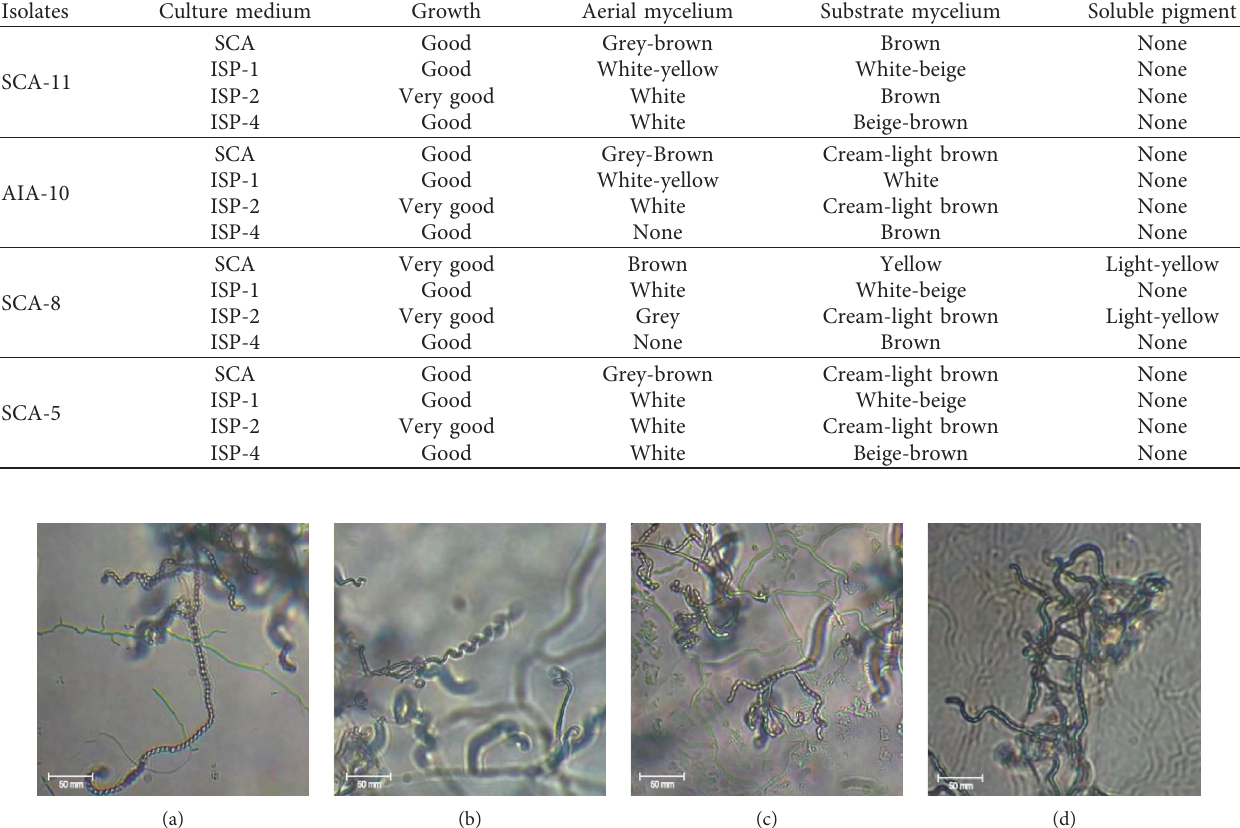
Figure 2: Phylogenetic tree of SCA-5, SCA-8, SCA-11, and AIA-10 constructed with the aid of MEGA 6.0 program. Table 3: Morphological characteristics of selected Streptomyces isolates on different media.